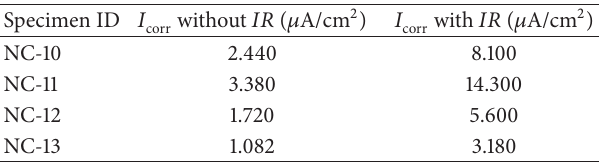
with and without IR compen- corr